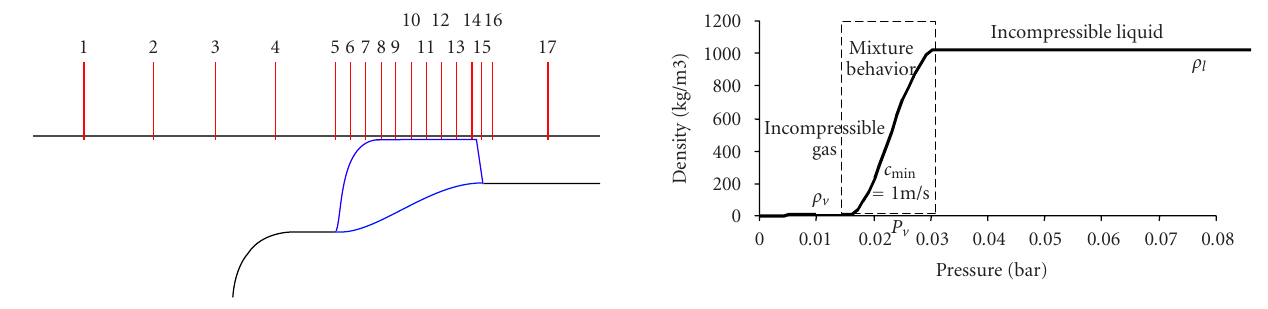
flow meter, with a relative accuracy of 0 . 3%, the rotation speed is controlled with a relative accuracy of 0 . 2%. The ref- erence velocity is the tangential velocity at the blades tip.